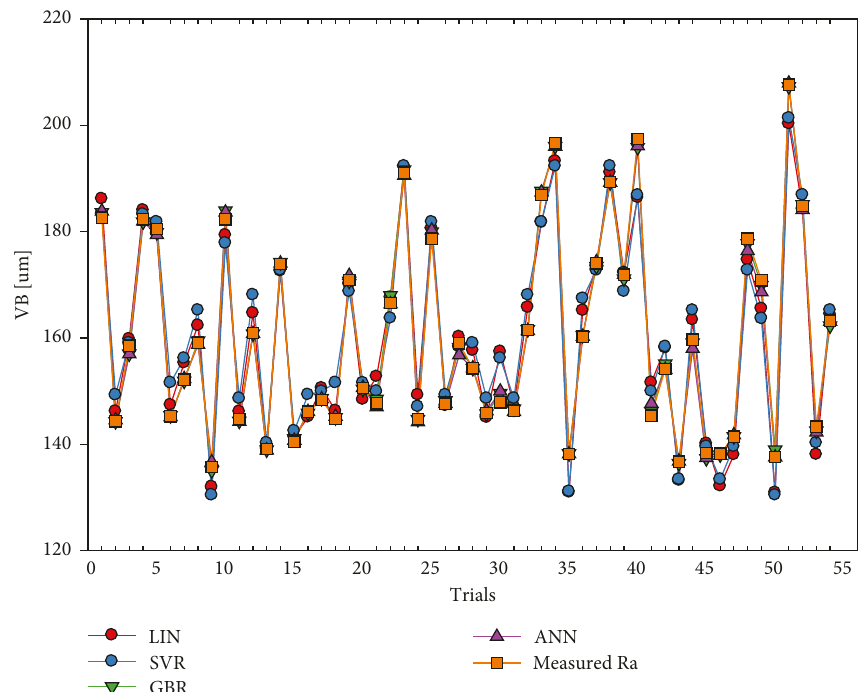
Figure 10: Comparison of experimental measurement and prediction of VB on the training dataset.